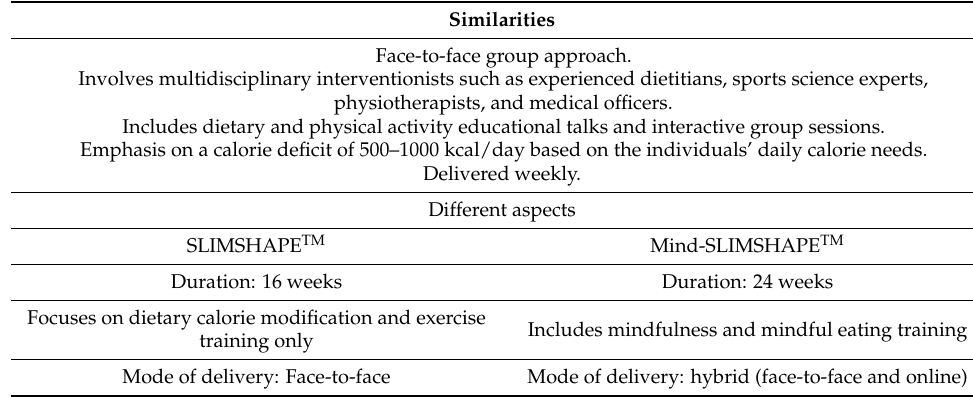
Table 1. Comparisons between SLIMSHAPE TM and Mind-SLIMSHAPE TM